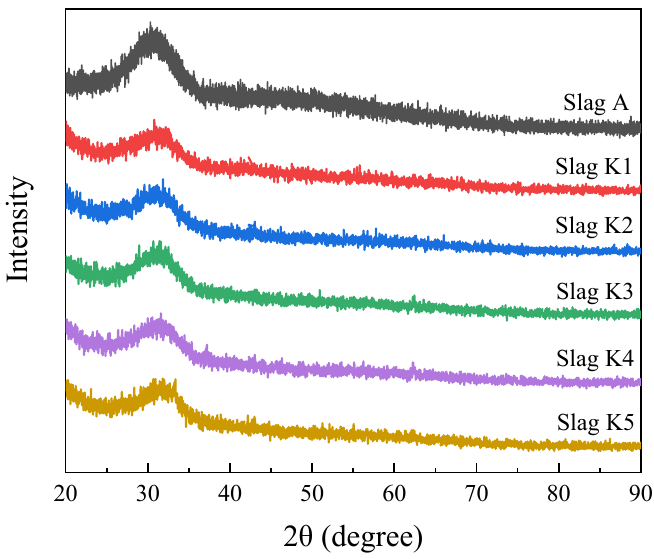
Figure 1. The XRD patterns of the pre-melted slags.